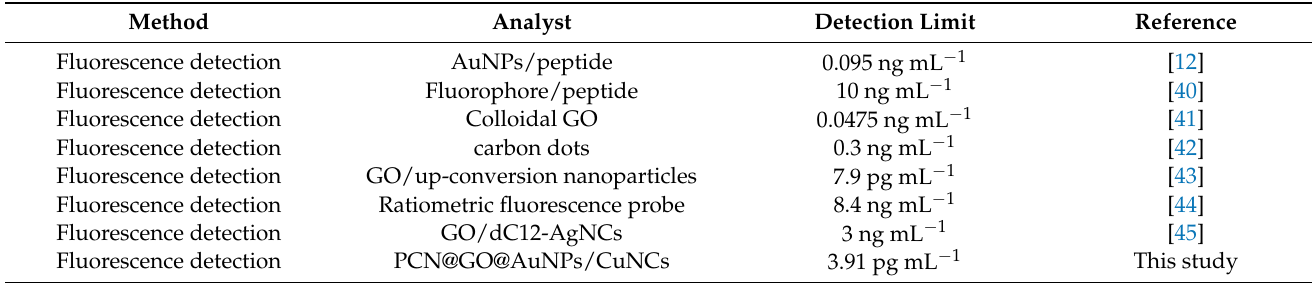
Table 1. Results for the detection of chymotrypsin.